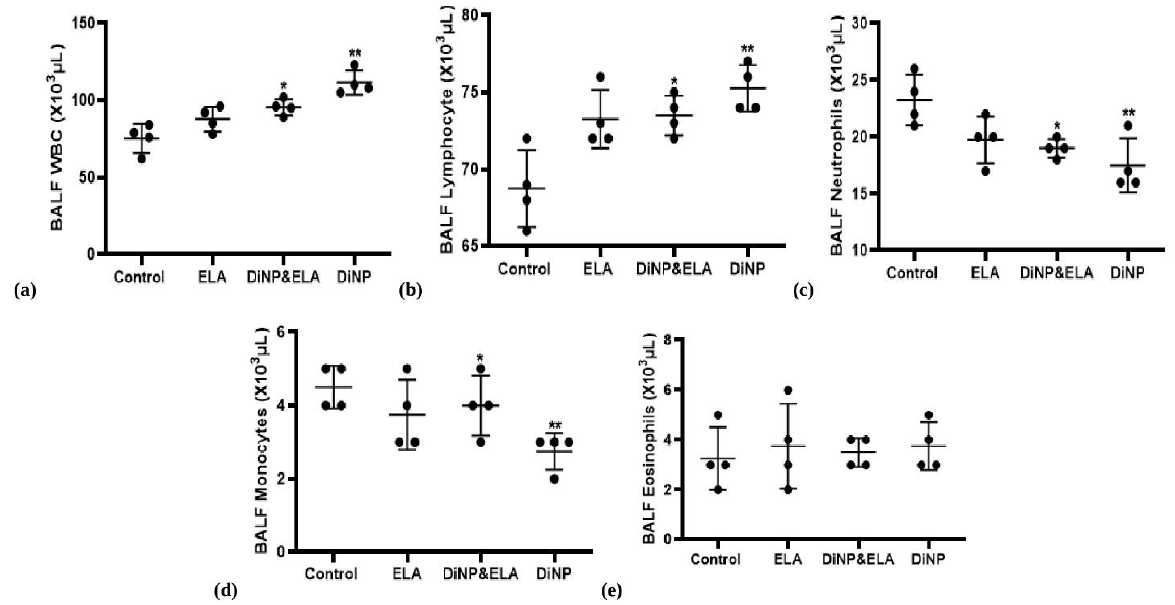
Note. Bronchoalveolar lavage fluid total cell count (a) WBC, (b) lymphocytes, (c) Neutrophils, (d) Monocytes, and (d) Eosinophils levels. The values are expressed as Mean ± SD of four mice (n = 4) in each group. WBC= White blood cells; BALF= Bronchoalveolar lavage fluid. *Significant difference (p < 0.05) between DiNP and